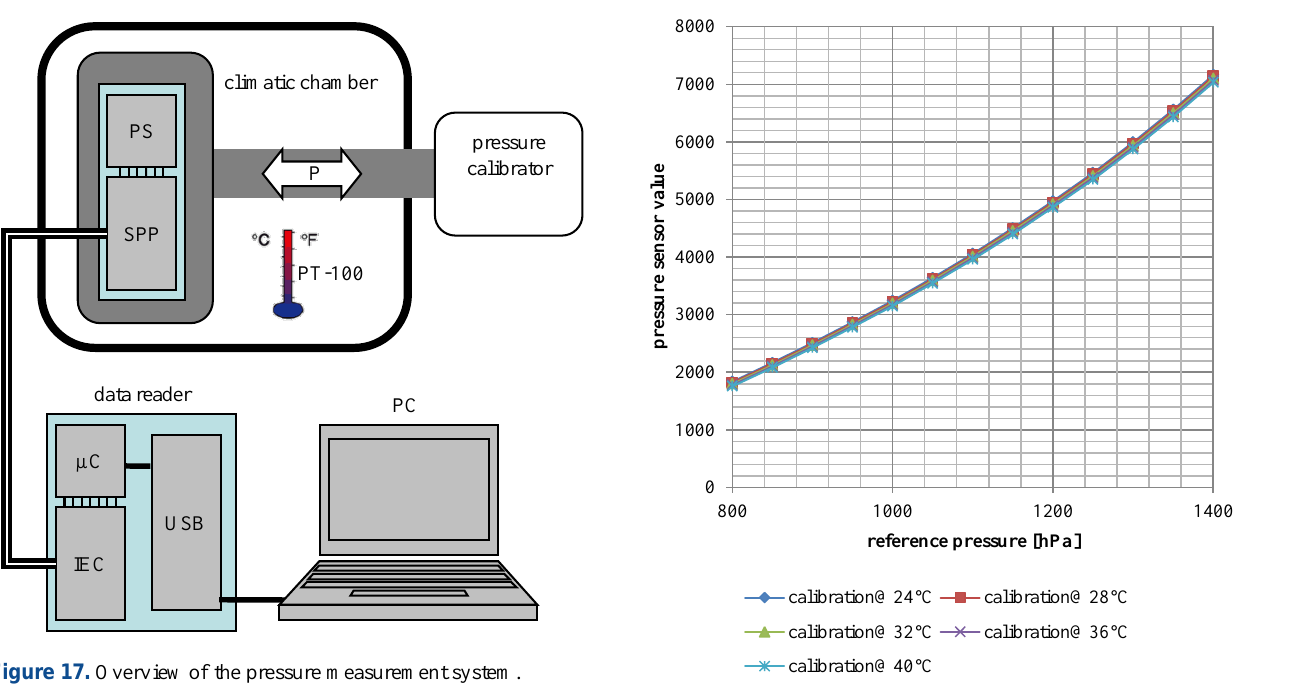
Figure 18. Pressure value of an encapsulated sensor module at var- ious temperatures in saline solution.